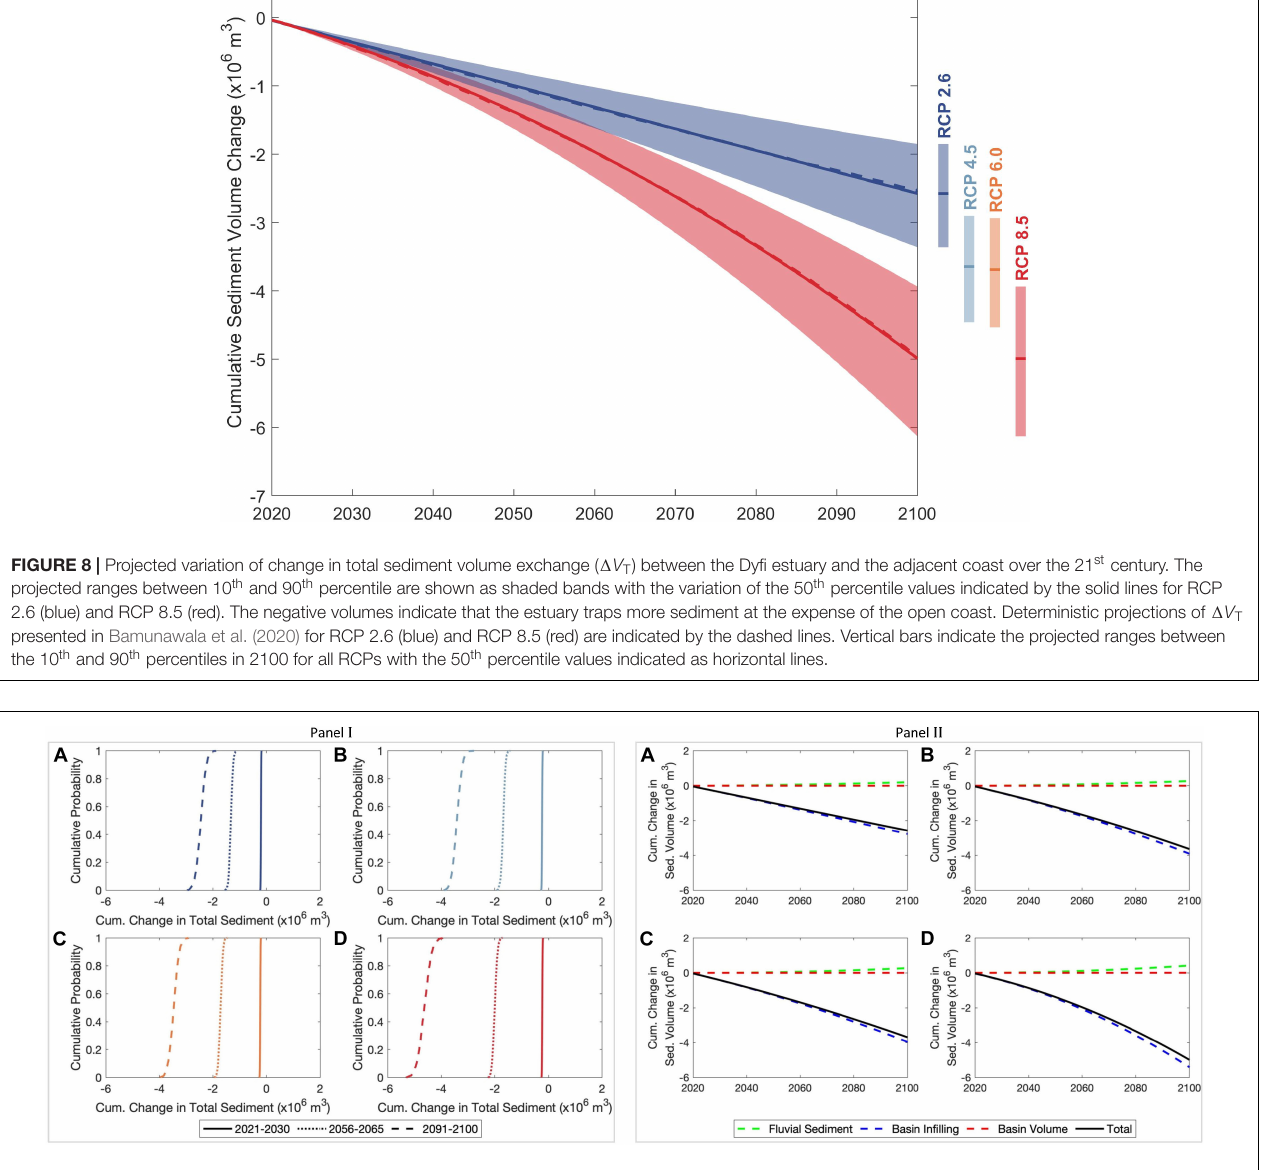
FIGURE 9 | Empirical cumulative distributions of the projected change in total sediment volume exchange ( (cid:49) V T ) between the Dyfi estuary and the adjacent coast over the three decadal periods considered (Panel I) . The empirical cumulative distributions were developed by averaging the projected (cid:49) V T values over the three decadal periods considered. (Panel II) shows the computed variations of the projected 50 th percentile values of change in total sediment volume exchange ( (cid:49) V T ) and contributions from different processes to (cid:49) V T at the Dyfi estuary over the 21 st century. Negative volumes indicate that the estuary traps more sediment at the expense of the open coast (i.e., sediment importing estuary). Subplots (A) , (B) , (C) , and (D) are for the RCPs 2.6, 4.5, 6.0, and 8.5,